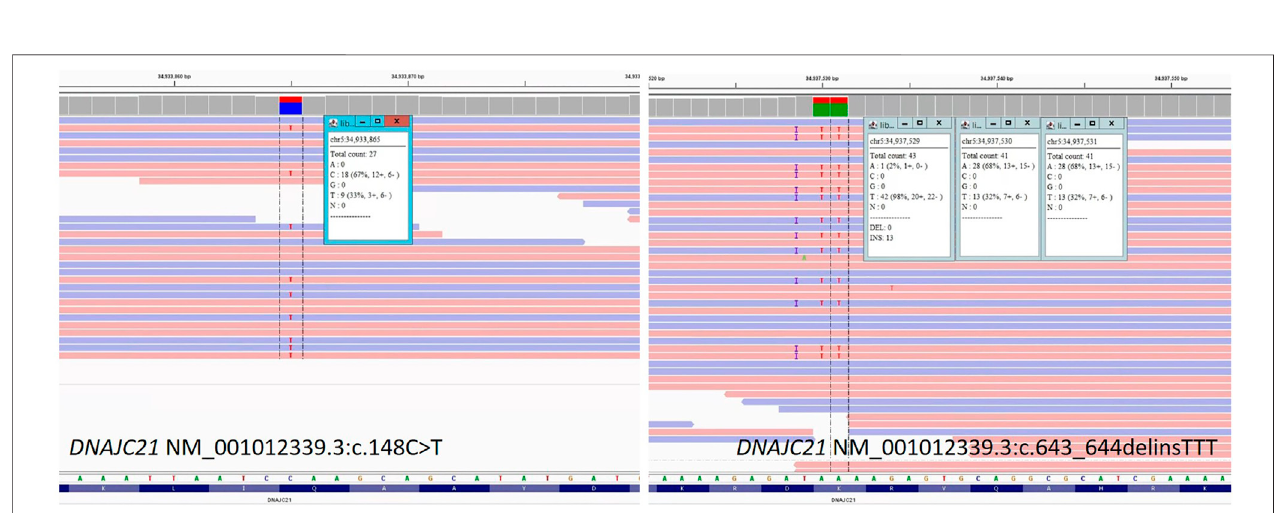
FIGURE 3 | Sequence image for the DNAJC21 gene: NM_001012339.3:c.148C > T and NM_001012339.3:c.643_644delinsTTT from patient ’ s whole-genome